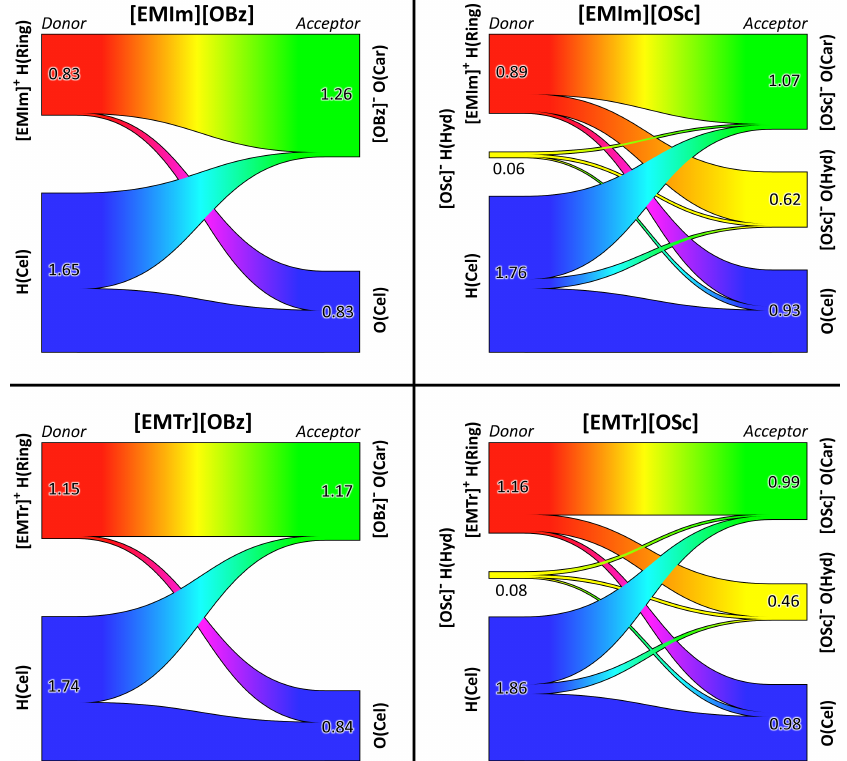
Figure 7. Sankey diagrams [53] visualizing the topology of the hydrogen bond network for the cellulose solution in the four ILs (one panel per IL). Hydrogen bond donors shown on the left side and acceptors on right-hand side. The numbers indicate the average hydrogen bond count per atom. For atom labels, see Figure 1.